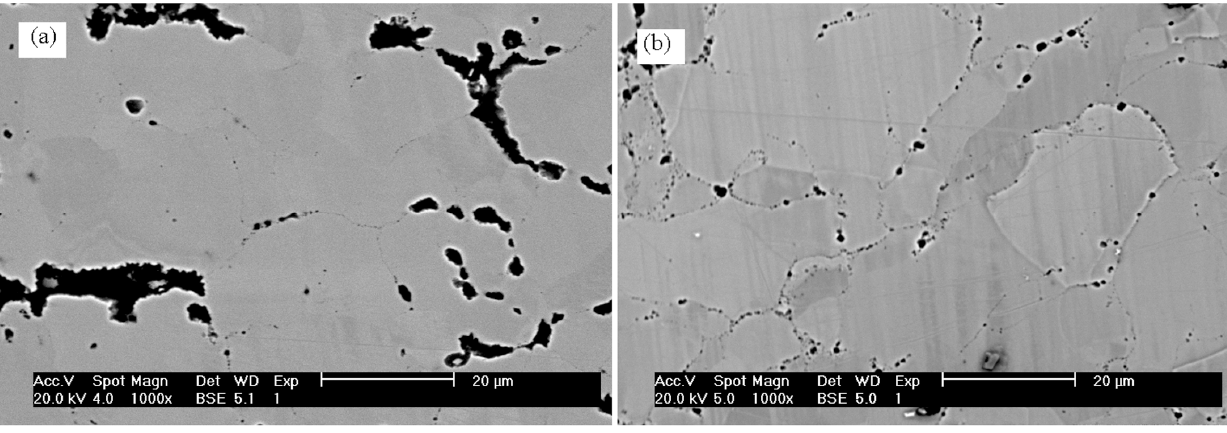
Figure 2. SEM microphotographs of FeAl sinter after the full heat treatment, ( a ) The pre-sintering at 620 °C, 0 Hz; ( b ) the pre-sintering at 670 °C, 60